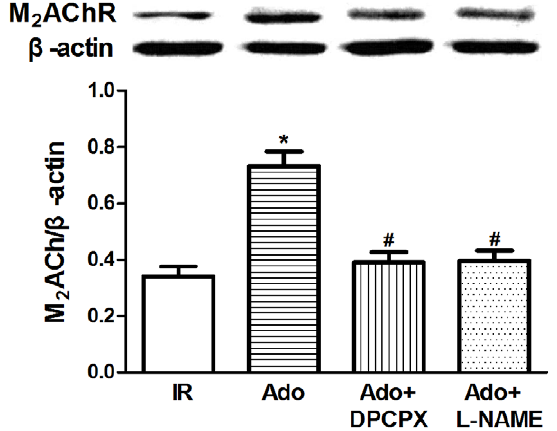
Figure 6. Effects of adenosine on the protein expression of M 2 AChR. Adenosine increased the protein level of M 2 AChR and DPCPX or L-NAME abolished this effect. IR: ischemic reperfusion; Ado: adenosine; * P , 0.01 vs. IR; # P , 0.01 vs. Ado (n=6 in each group).